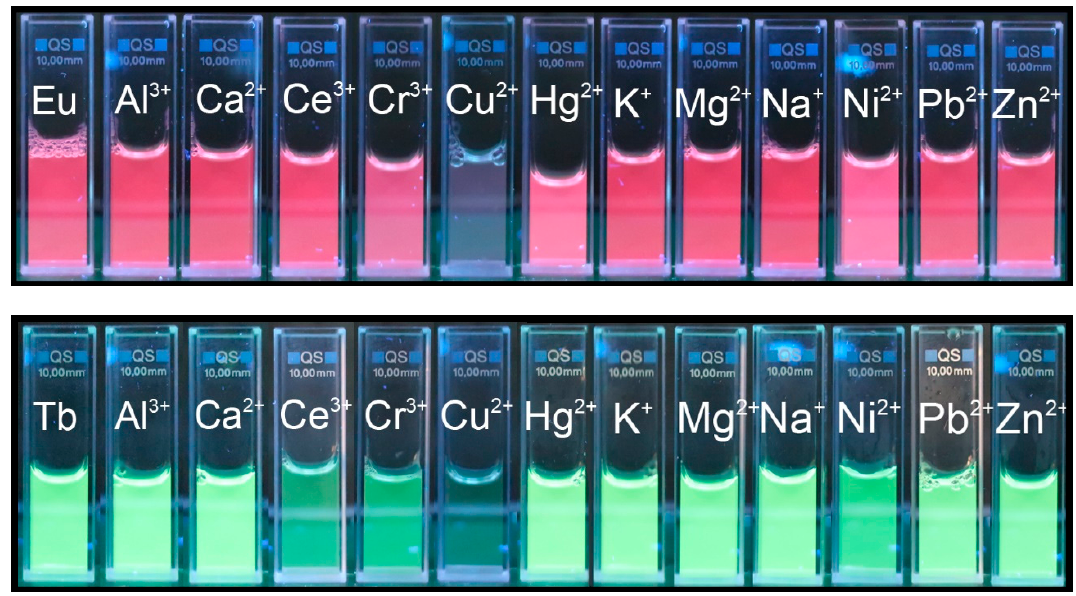
Figure 4. Fluorescence photographs of Eu 3 + / PSA (red) and Tb 3 + / PSA (green) alone (first to the left in each row), and in the presence of 3.33 mM of metal ions under UV light (365 nm) in aqueous solution.